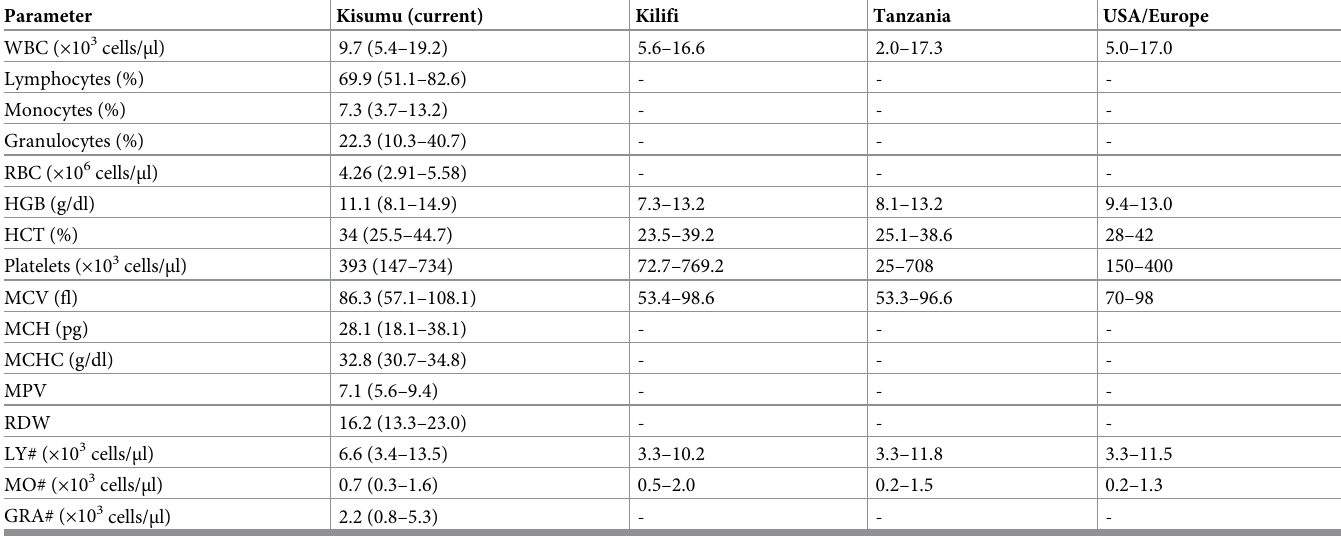
Table 7. Comparison of 95% hematological reference intervals for infants aged 1m to less than 12months between Kisumu, Kilifi, Tanzania and United States/ Europe.